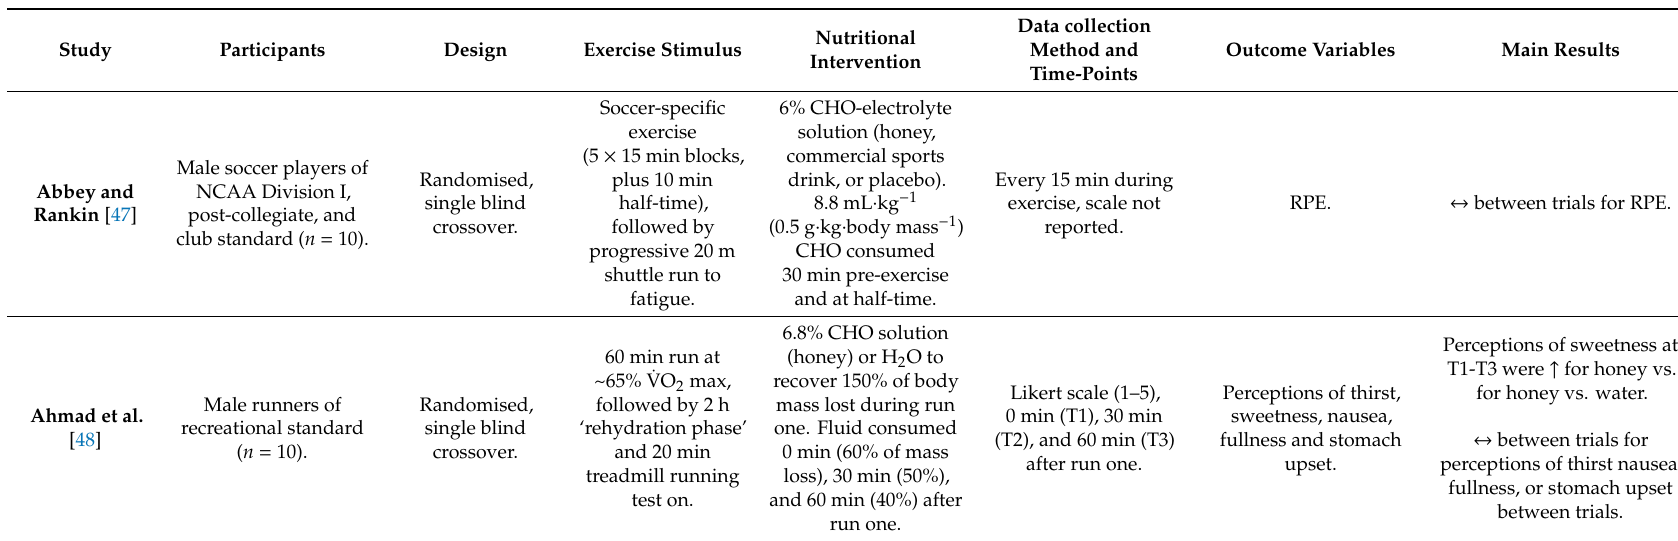
Table 4. Studies examining the e ff ect of honey supplementation on perceptual responses around